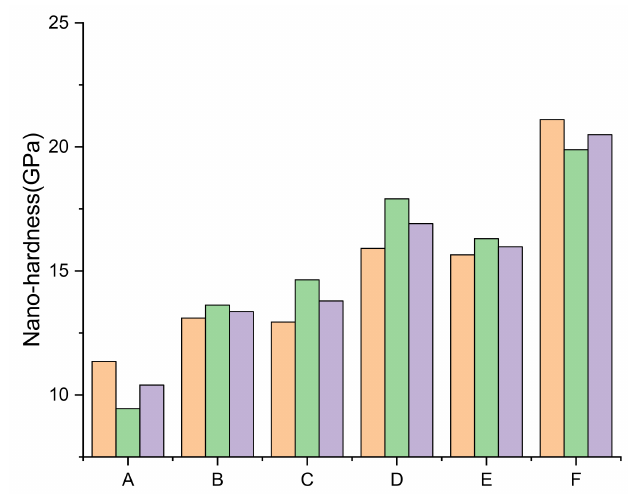
Figure 9. Distribution range of hardness test values in gray area.